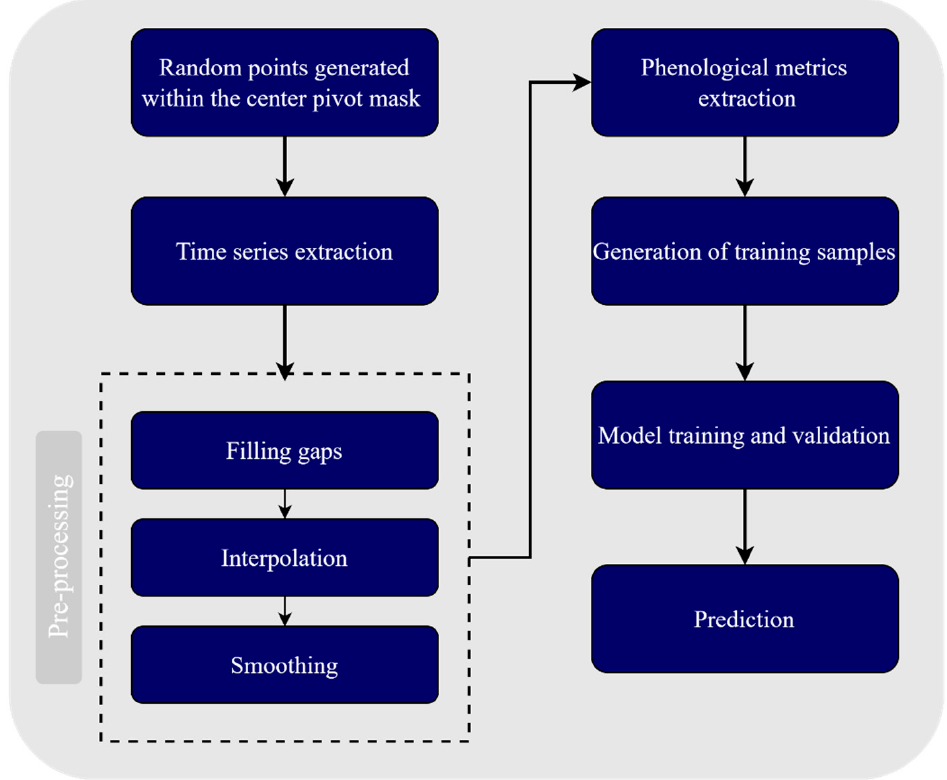
Figure 3. Flowchart of processing steps for mapping crops in the center pivots.